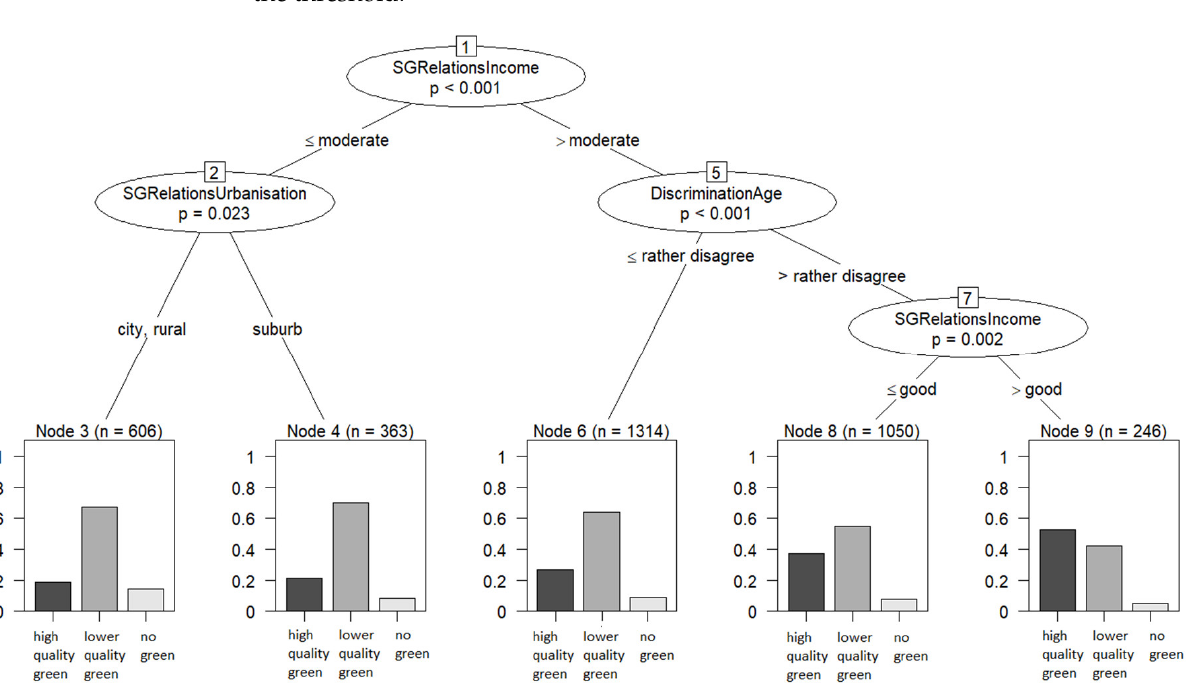
Figure 1. CIT tree for the exposure measure access to high quality public green space (subjectively measured). Bars in the bottom row show the proportion of participants in each exposure category.